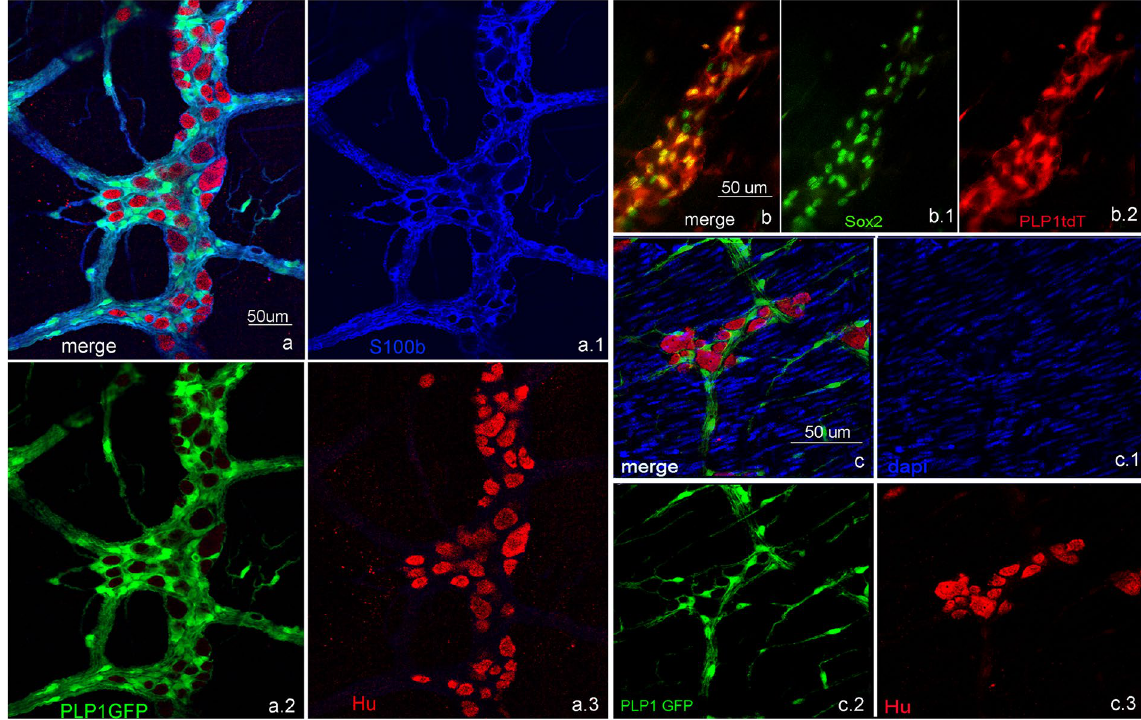
Figure 5. PLP1 is expressed by enteric glia and not neurons. PLP1tdT + cells co-express S100b ( a ). PLP1tdT expressing cells also express Sox2 ( b ). In PLP1GFP mice, enteric neurons are not GFP + in the adult gut ( c ). (All images of Fig. 5 were taken at